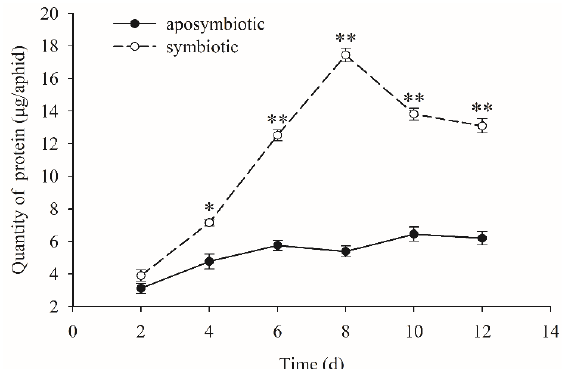
Figure 2. Dynamic changes of protein content in pea aphids that were Buchnera absent or infected. Black dot: rifampicin-treated aphid; Clear circle: healthy control aphid. The black dot or clear circle and error bars were the mean ± standard error. The star “ * ” means significant differences between the antibiotic-treated and control aphids at 0.05, the double star “ ** ” means significant differences between the antibiotic-treated and control aphids at 0.01. ( t = 2.344, df = 16, p = 0.041 on day 4; t = 5.991, df = 16, p < 0.01 on day 6; t = 7.155, df = 16, p < 0.01 on day 8; t = 5.321, df = 16, p < 0.01 on day 10; t = 3.765, df = 16, p ≤ 0.01 on day 12).